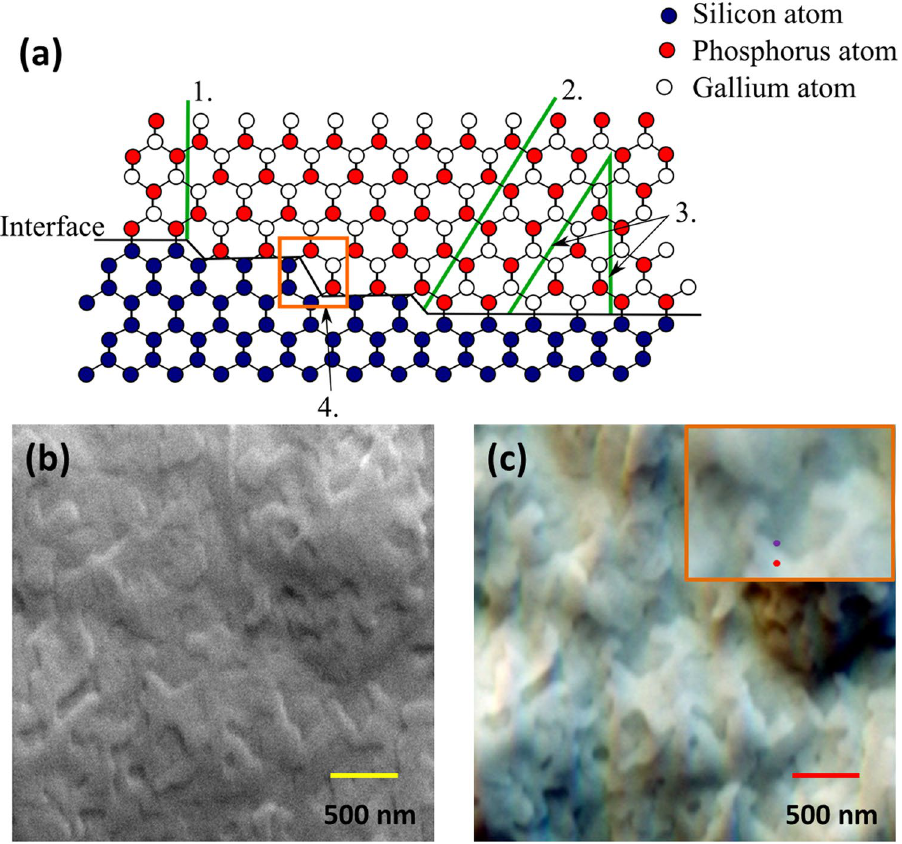
Figure 1. Antiphase domains in GaP on Si substrates. ( a ) Ball and stick model illustrating the formation and annihilation of antiphase boundaries (APBs) in GaP grown on a (001) Si, (1.) APBs parallel to (110) due to sub-lattice occupation disorder, (2.) APBs along the {111} Si due to monoatomic steps, (3.) annihilation of APBs along (111) and (110) and (4.) annihilation of APBs due to diatomic steps. (b) Plan-view secondary electron image and ( c ). Plan-view backscattered electron image both acquired at a sample tilt of 70° from the same region of the surface of a 70 nm GaP film grown on an (001) Si substrate (miscut < 0.1°). The inset shows areas marked with a red dot and a purple dot which may well be regions with two orientations corresponding to a difference in the location of cation atoms (eg. Ga) and anion atoms (P) in the two sub-lattices as expected in the case of